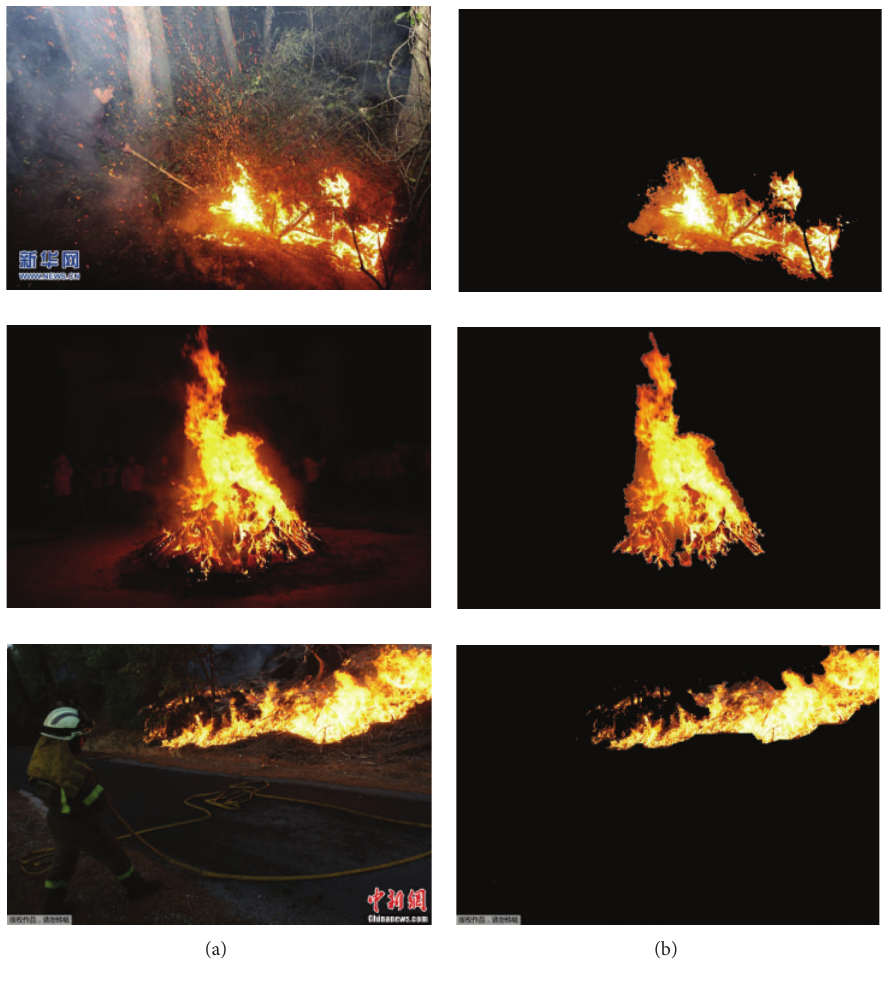
Figure 3: Sample images and manually marked